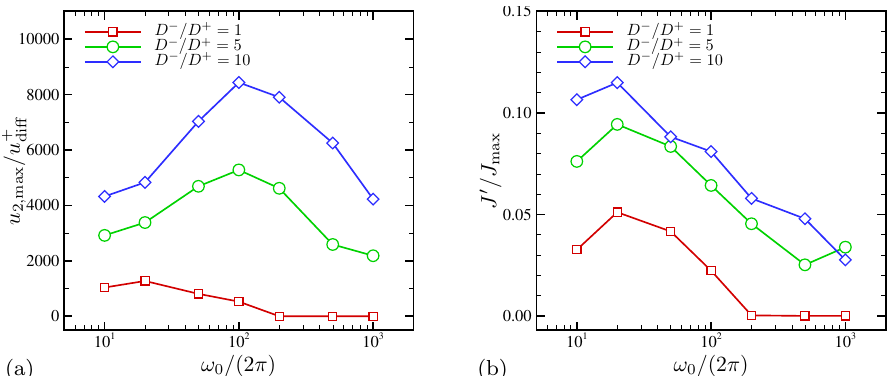
Figure 18. ( a ) Normalized maximum wall-normal velocities and ( b ) normalized surface current density fluctuations in the horizontal direction.